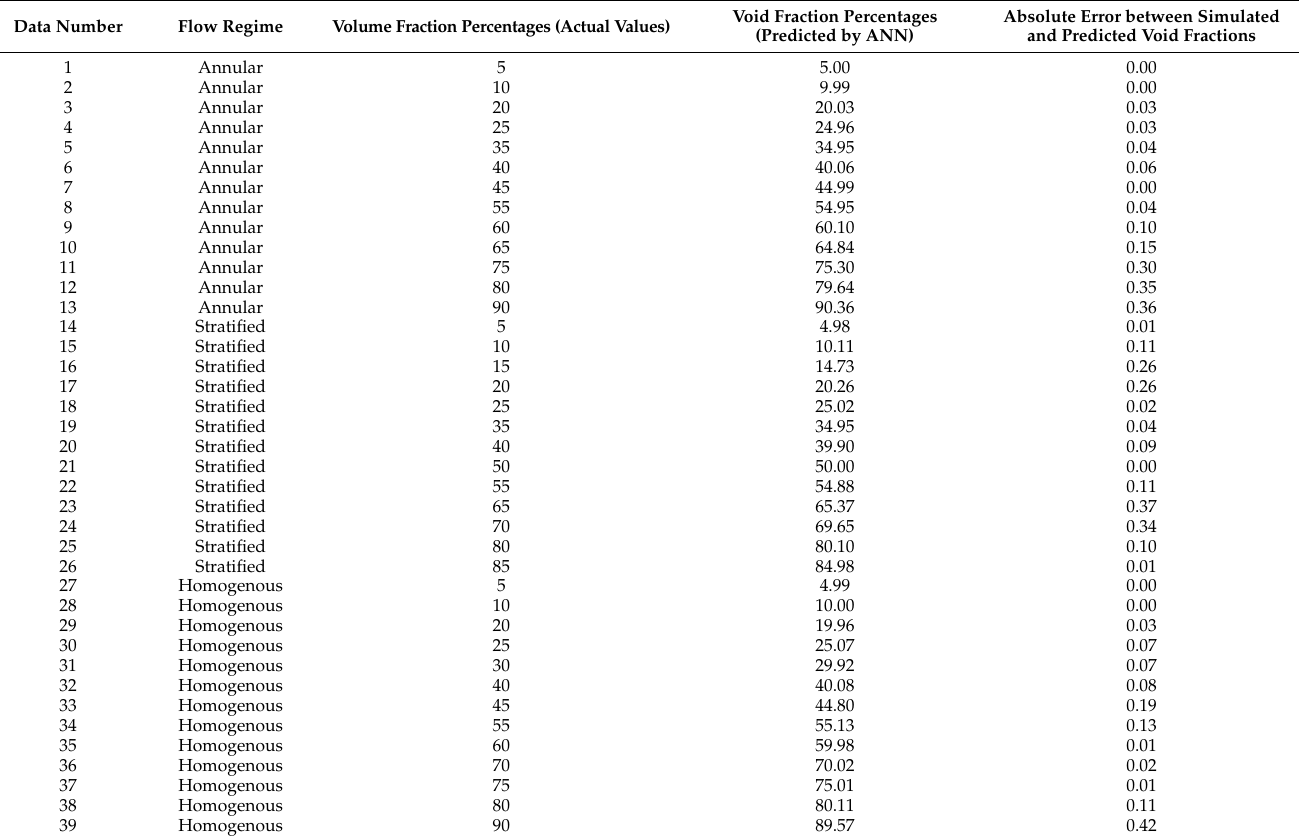
Table 5. A comparison of the actual and predicted values of volumetric percentages (training